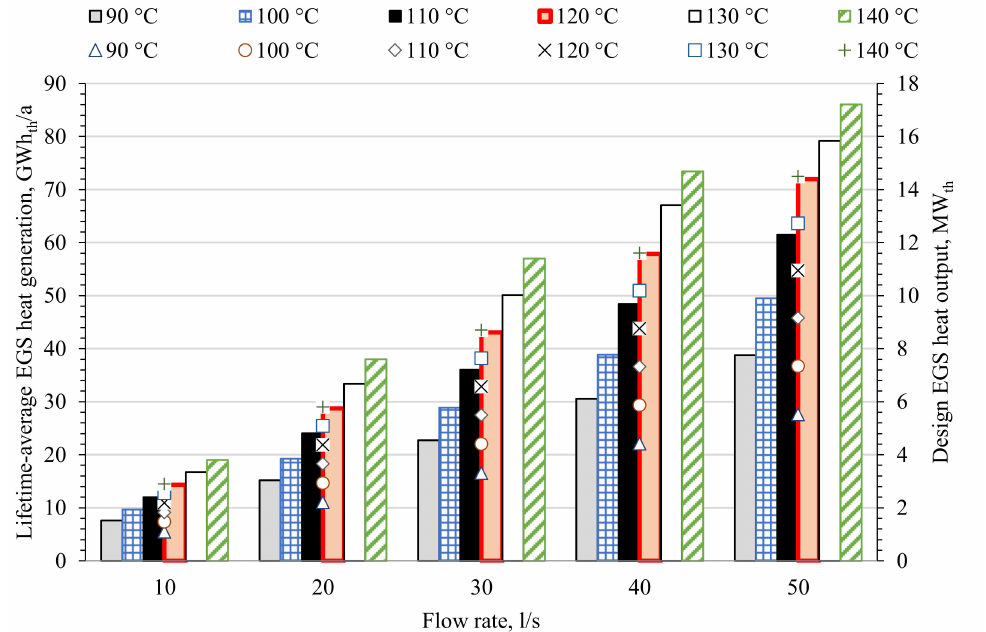
Figure 3. Lifetime-average EGS heat generation (columns) and design EGS heat output (symbols) for the reference